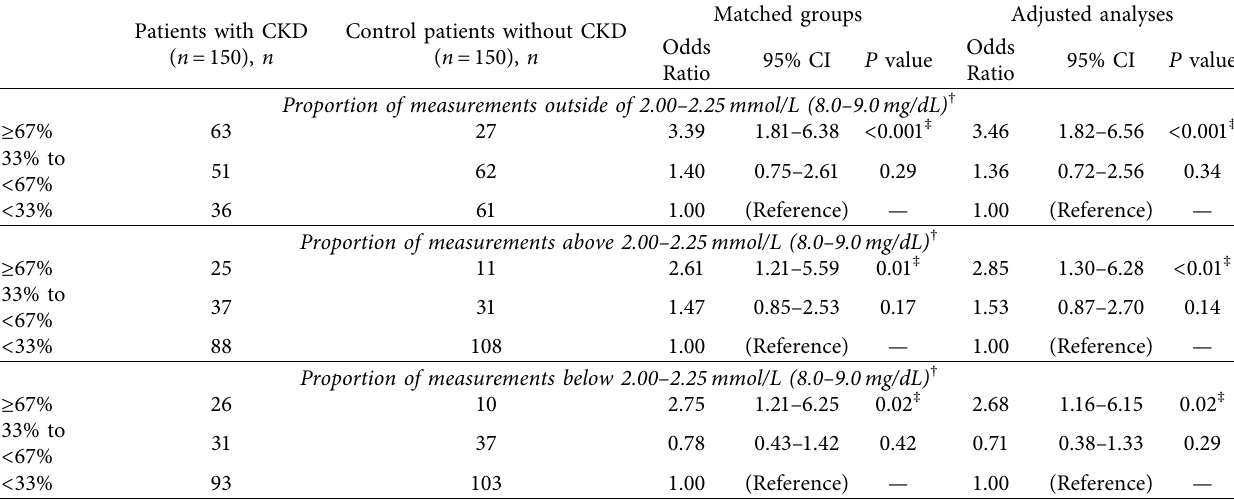
Table 2: Association between albumin-corrected serum calcium and development of CKD ∗ . Patients with CKD ( n � 150), n